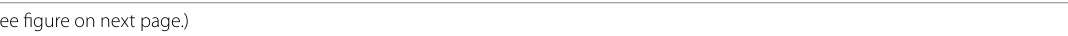
figure on next Fig. 5 Histopathological examinations of the lung ( A1, A2 ), liver ( B1, B2 ), and spleen ( C1, C2 ) in unimmunized and passively immunized mice challenged with A. baumannii . The bacterial challenge caused an increasing number of neutrophils around the peribronchial and perivascular areas in unimmunized mouse lungs ( A1 ) while immunized mice revealed moderate inflammation with infiltration of mixed mononuclear cells and neutrophils ( A2 ). The livers of unimmunized mice show inflammation and necrosis ( B1 ). In contrast, the livers from immunized mice showed no significant pathology ( B2 ). The spleen of unimmunized mice showed hyperplasia of the white pulp and higher neutrophils ( C1 ) as against the normal structure retained in the immunized group ( C2